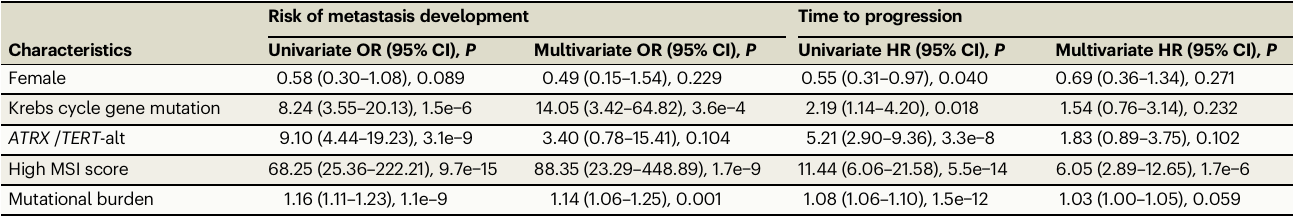
Table 1 | Univariate and multivariate logistic and Cox regression analysis of metastasis risk and